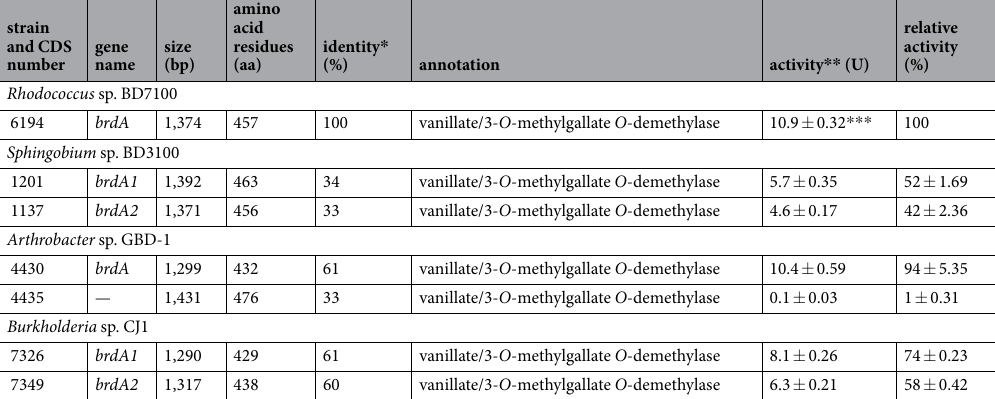
Table 1. Characterization of BrdA homologs in BBR-utilizing bacteria. * Amino acid sequence identity with BrdA of BD7100. ** One unit of BBR-degrading activity was defined as degradation of 1 µ M BBR per minute using 5 µ g/ml of purified His-BrdA enzyme. Each value is the average of triplicate measurements. *** ± Indicate standard error of triplicate